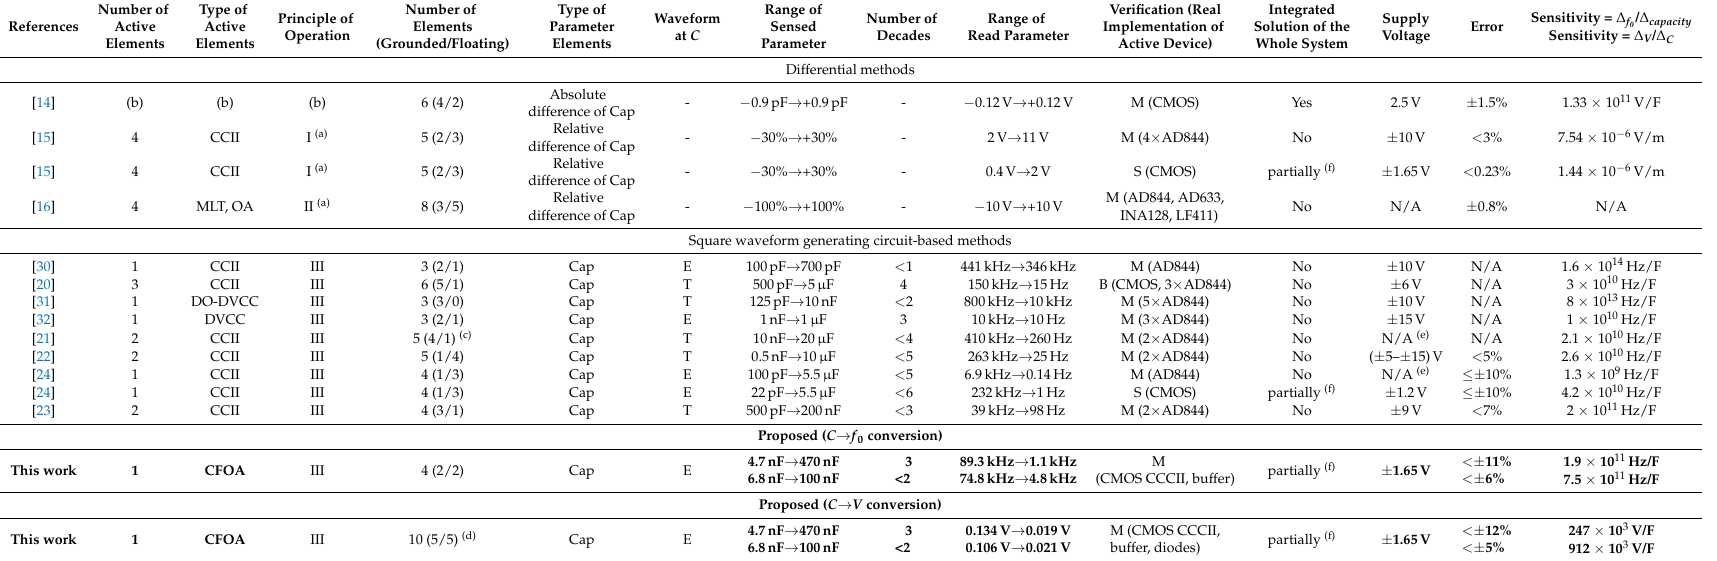
Table 1. Comparison of analog continuous-time operating capacitive sensor interfaces from recent literature (our work is indicated with bold